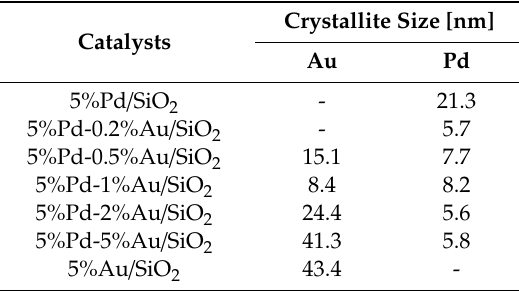
Table 3. Metal particle size of Pd-Au / SiO 2 catalysts calculated on the basis of XRD studies according to the Scherrer